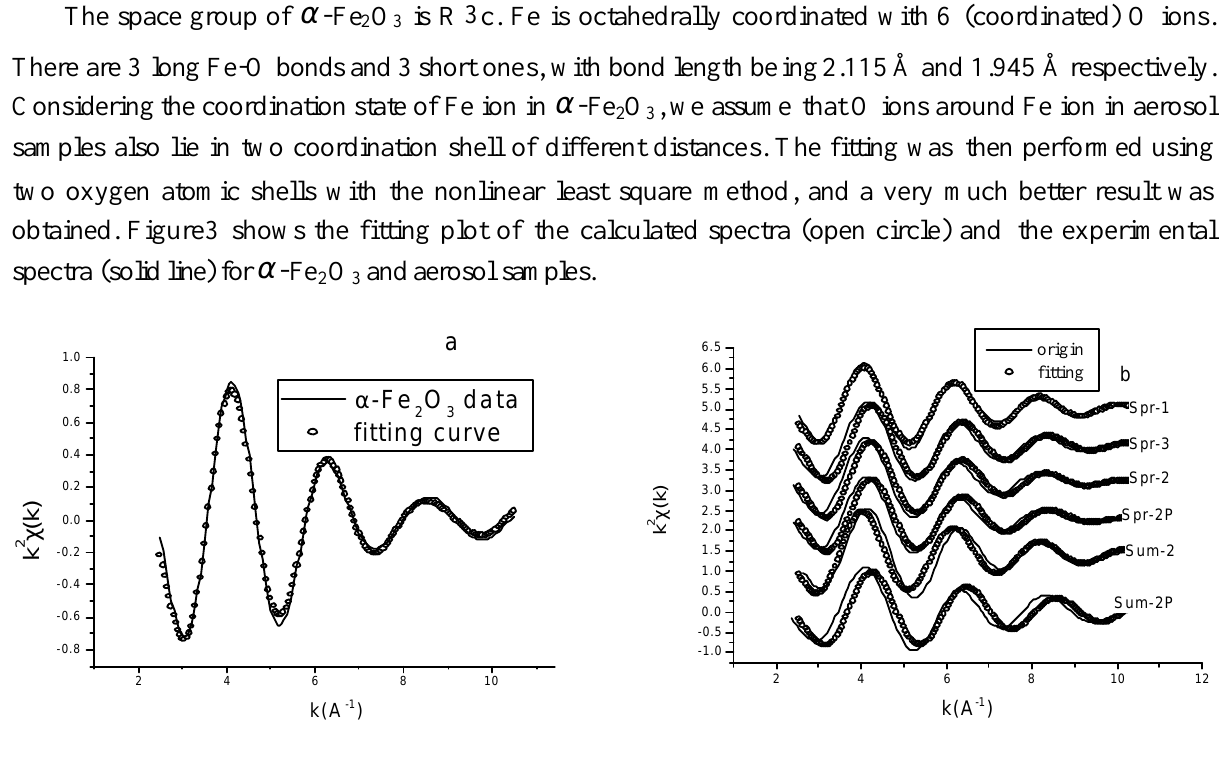
Figure 3. k 2 -Weighted EXAFS and the fitting curve for iron K-edge of Fe-O coordination shell of a -Fe 2 O 3 ( a ) and aerosol samples ( b